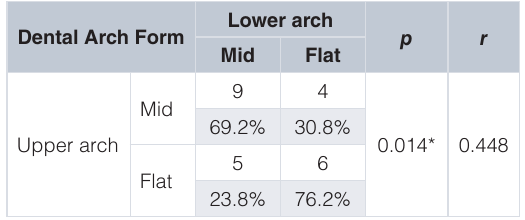
Table 6. Correlation of upper and lower dental arch form in condylar hyperplasia patients.